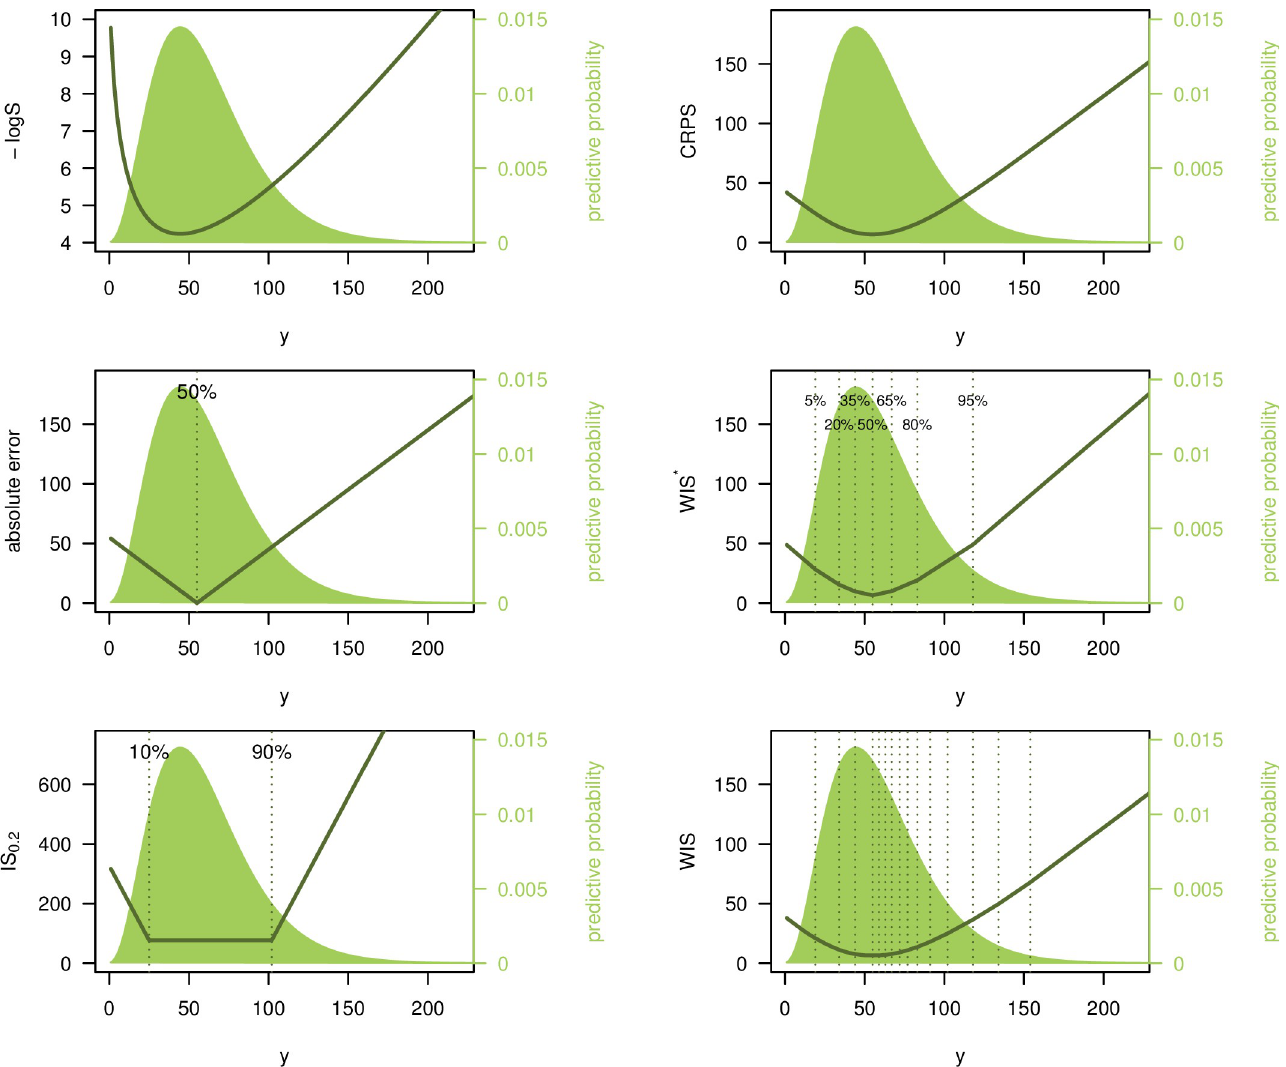
Fig 2. Illustration of different scoring rules. Logarithmic score, absolute error, interval score (with α = 0.2 ), CRPS, and 2 versions of the weighted interval score. These are denoted by WIS � (with K = 3 , α 1 = 0.1, α 2 = 0.4, α 3 = 0.7 ) and WIS ( K = 11, α 1 = 0.02, α 2 = 0.05, α 3 = 0.1, ... , α 11 = 0.9 ). Scores are shown as a function of the observed value y . The predictive distribution F is negative binomial with expectation 60 and size 4. Note that the top left panel shows the negative logS , i.e., − logS , which, like the other scores, is negatively oriented (smaller values are better).